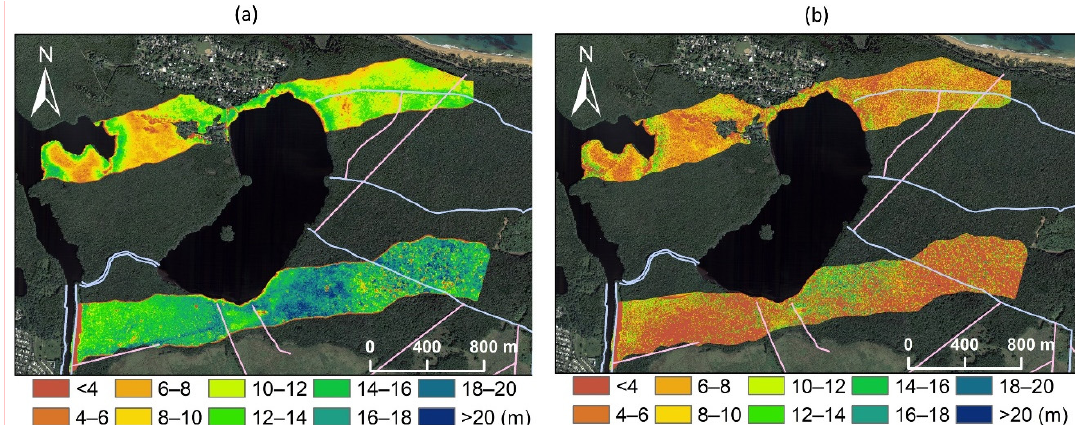
Figure 2. The LiDAR-detected canopy height model for ( a ) intact (pre-hurricane) and ( b ) disturbed (post-hurricane) mangrove forest along the north and south transects. The changes in canopy height were illustrated in Figure 6 a.